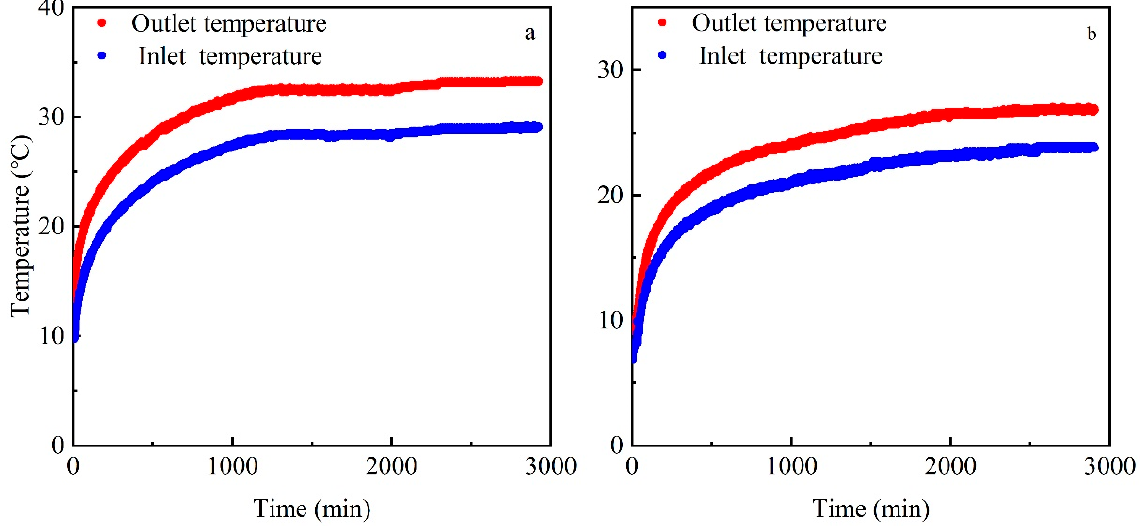
Figure 6. Inlet and outlet time ‒ temperature curves. ( a ) Condition A. ( b ) Condition B.